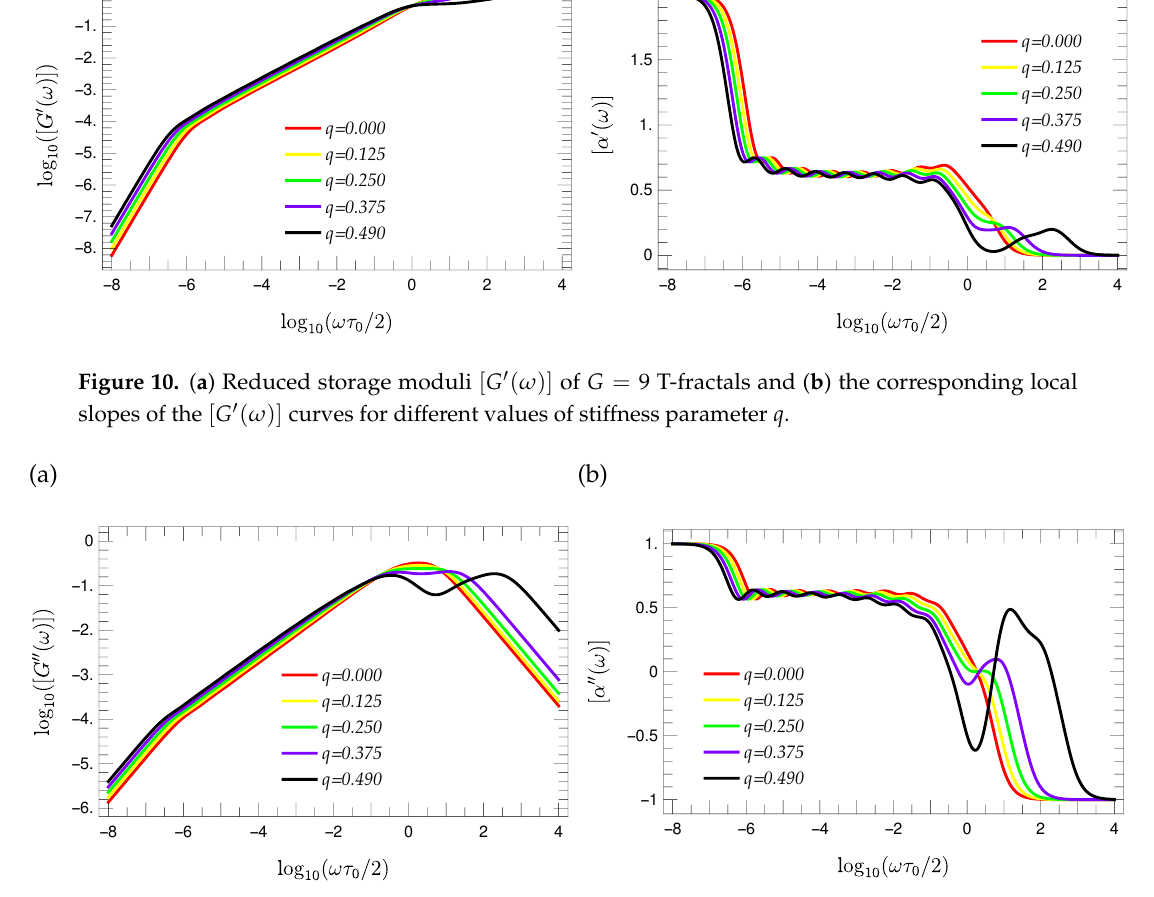
Figure 11. ( a ) Reduced loss moduli [ G (cid:48)(cid:48) ( ω )] of G = 9 T-fractals and ( b ) the corresponding local slopes of the [ G (cid:48)(cid:48) ( ω )] curves for different values of stiffness parameter q .